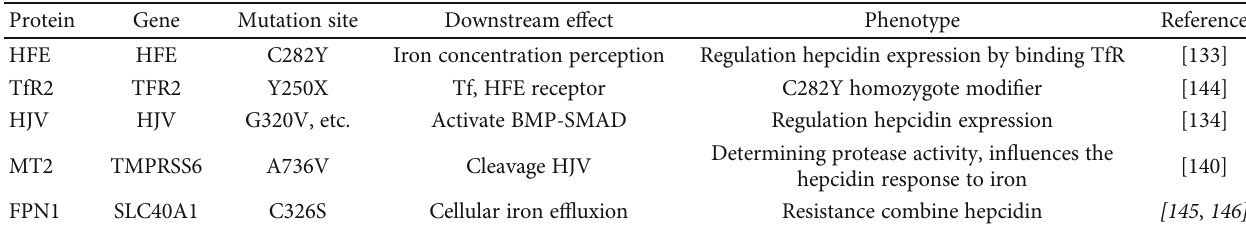
Table 1: Genetic mutation causes iron metabolism